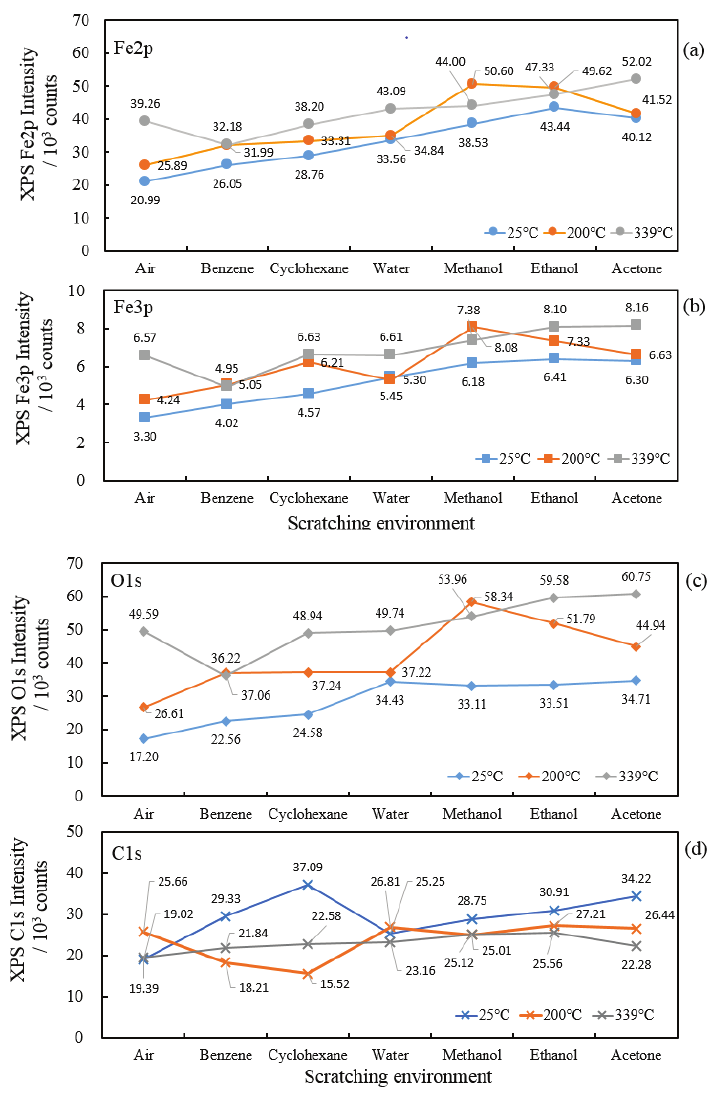
Figure 4. Dependence of the total number of electrons counted, termed X-ray photoelectron Figure4. Dependenceofthetotalnumberofelectronscounted, termedX-rayphotoelectronspectroscopy (XPS) intensity, in the Fe 2 p ( a ), Fe 3 p ( b ), O 1 s ( c ), and C 1 s ( d ) spectra in the XPS measurements after the photoelectron emission (PE) measurement at 25, 200, and 339 ◦ C for real iron surfaces on the scratching environments in the following order: (1) air, (2) benzene, (3) cyclohexane, (4) water, (5) methanol, (6) ethanol, and (7)